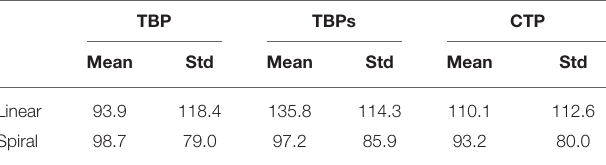
TABLE 1 | Summary of the tracking precision results.